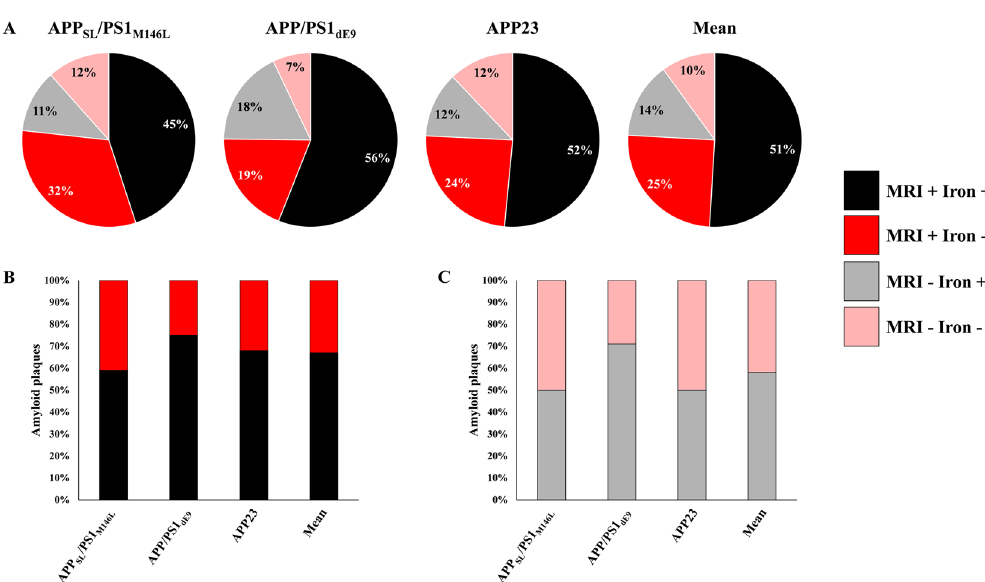
Figure 6. Detectability of amyloid plaques by Gd-stained MRI according to their iron content. Cortical amyloid plaques with a diameter ≥ 36 µ m were categorized into one of the following four categories: iron-positive plaques detected by MRI (MRI + Iron + , black), iron-negative plaques detected by MRI (MRI + Iron − , red), iron-positive plaques not detected by MRI (MRI − Iron + , grey) and iron-negative plaques not detected by MRI (MRI − Iron − , pink) in APP SL /PS1 M146L , APP/PS1 dE9 and APP23 mice ( A ). Among amyloid plaques detected by Gd-stained MRI, 59%, 75% and 68% contained iron in APP SL /PS1 M146L , APP/PS1 dE9 and APP23 mice, respectively ( B ). Among amyloid plaques not detected by Gd-stained MRI, 50%, 71% and 50% contained iron in APP SL /PS1 M146L , APP/PS1 dE9 and APP23 mice, respectively ( C